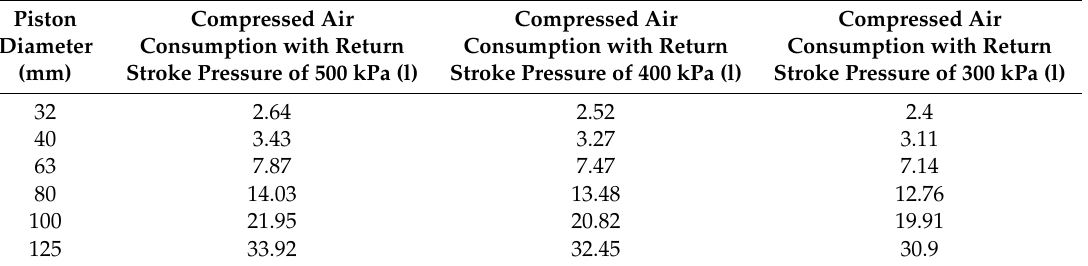
Table 2. Air consumption results for the system in Figure 1b.